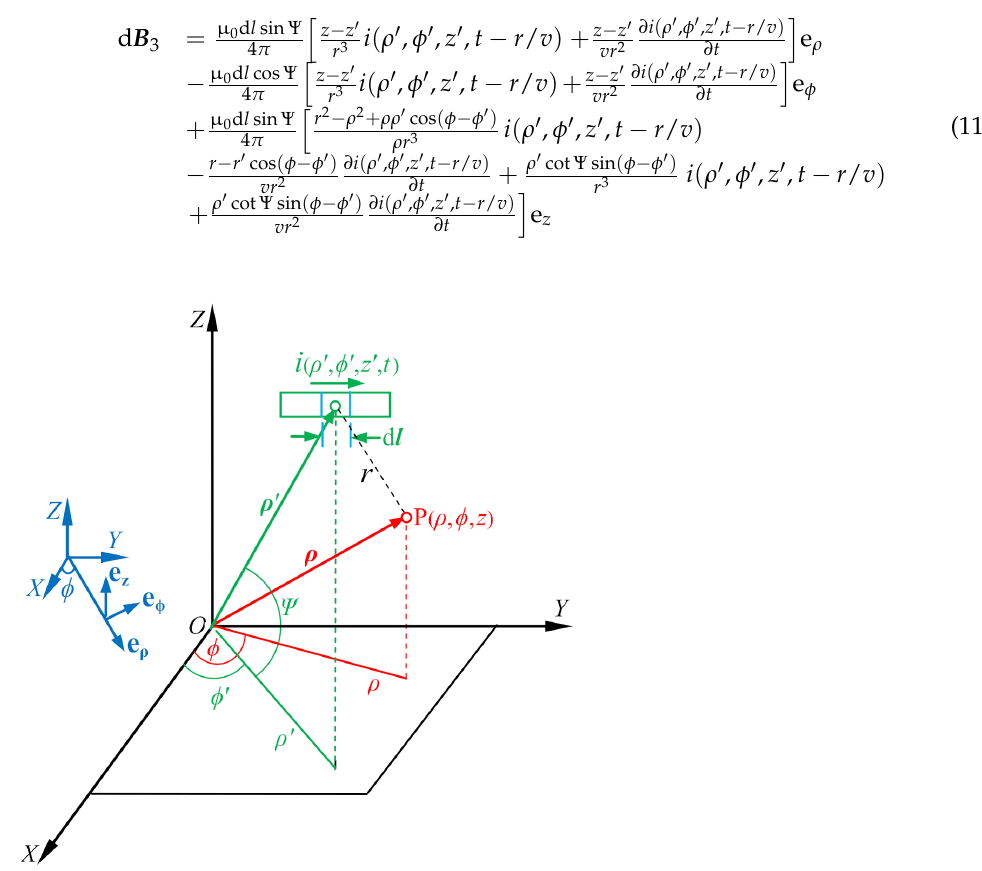
Figure 5. Horizontal